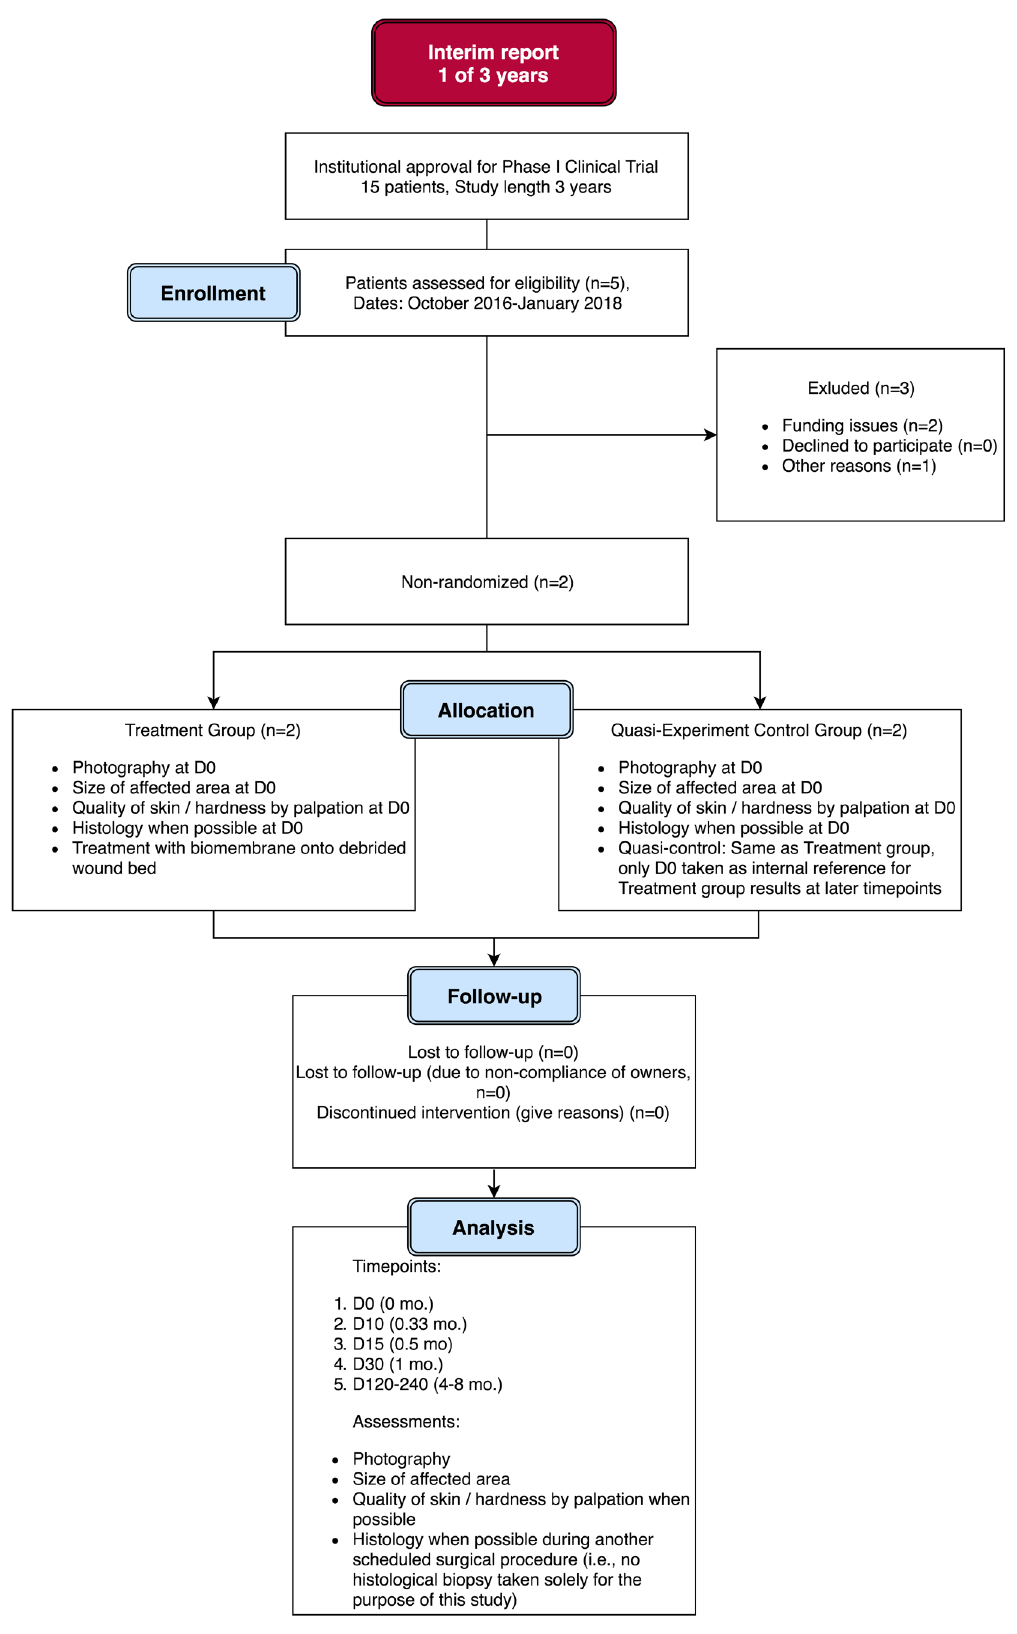
Figure 1. Study flow